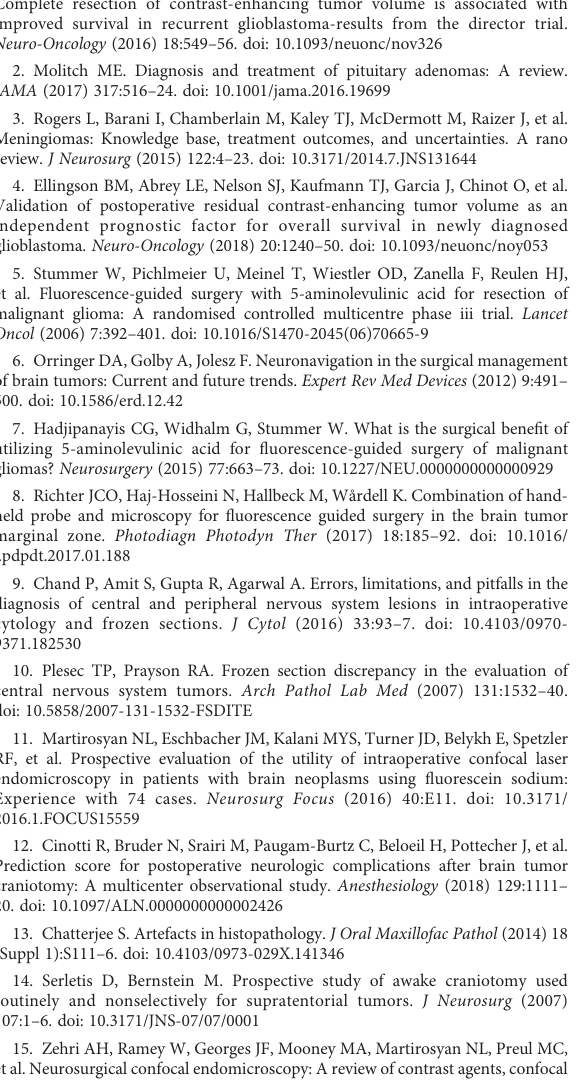
SUPPLEMENTARY VIDEO 2 Real-time examination of the pituitary adenoma tissue from resected human specimen. The H&E stained, and CLE scanned images from the same tissue were presented in Figure 5A and Supplementary Figure 2A.